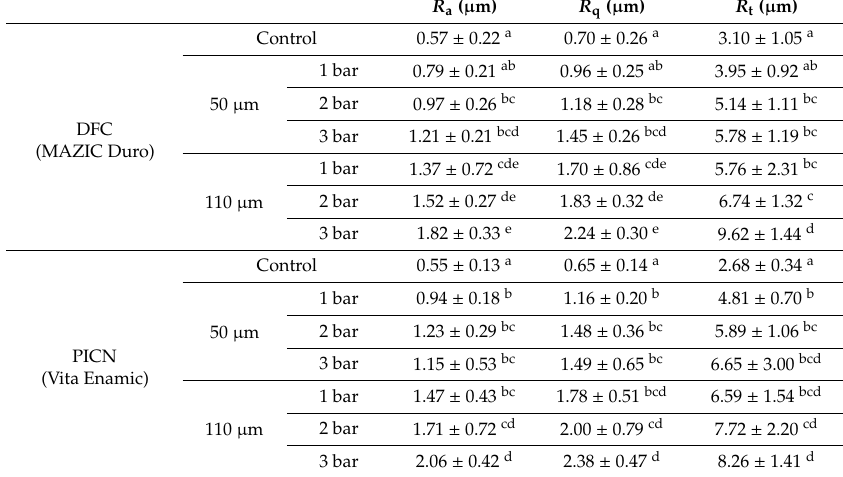
Table 2. Surface roughness of disperse-filled composites (DFC) and polymer-infiltrated ceramic networks (PICN) groups subjected to air abrasion at di ff erent pressures with alumina particles of di ff erent